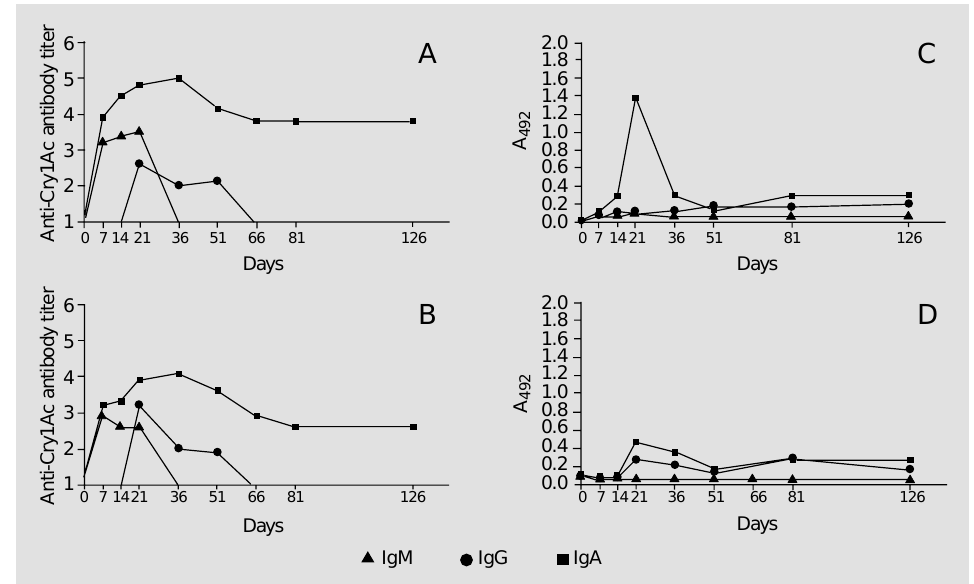
Figure 1 - Kinetics of serum (A and B) and intestinal (C and D) anti-pCry1Ac antibody produc- tion. Mice were immunized with 100 µg of pCry1Ac by the ip (A and C) or ig (B and D) route. Sera and feces from five mice were pooled and the IgM (triangles), IgG (circles) and IgA (squares) antibody contents were deter- mined by ELISA. Nonimmunized mice showed antibody titers <1 in serum and A 492 <1 in fecal